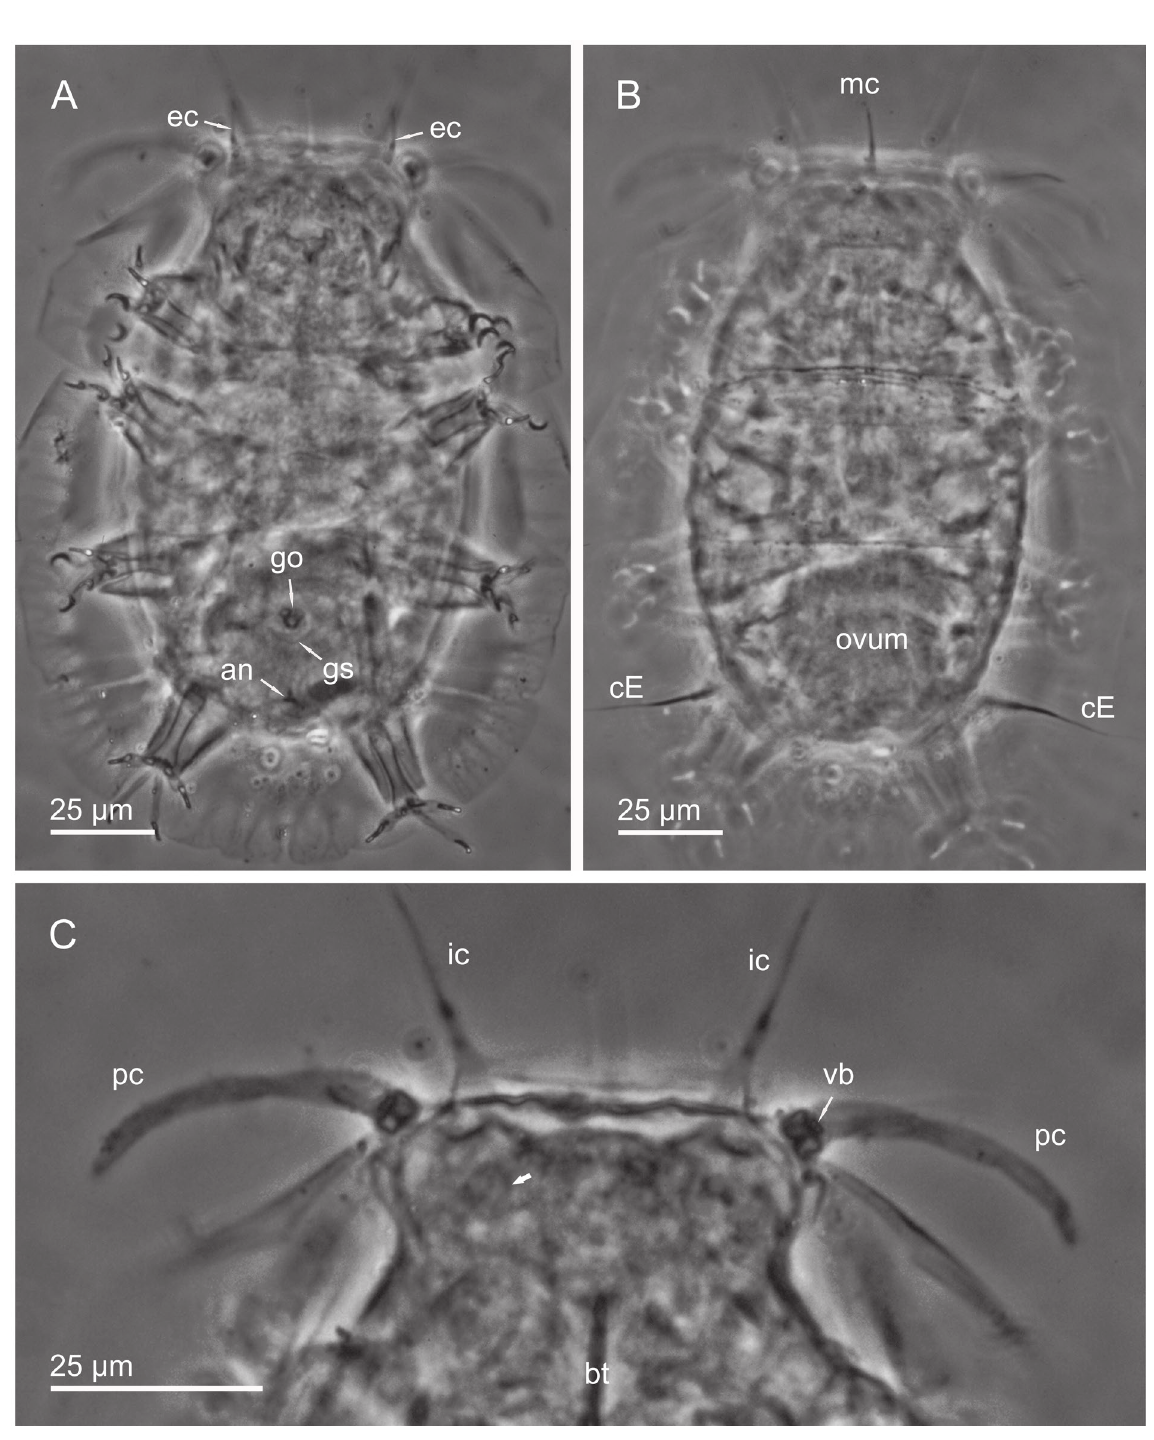
Fig. 11. PhC-micrographs of Higginsarctus lassei gen. et sp. nov., holotype, ♀ (NHMD-293913). A . Ventral overview. B . Dorsal overview showing the metameric folds of the dorsal cuticle. C . Close up on the head, ventral view showing the weak indication of secondary clava (white solid arrow), internal cirri and primary clavae with van der Land’s body. Abbreviations: see Material and